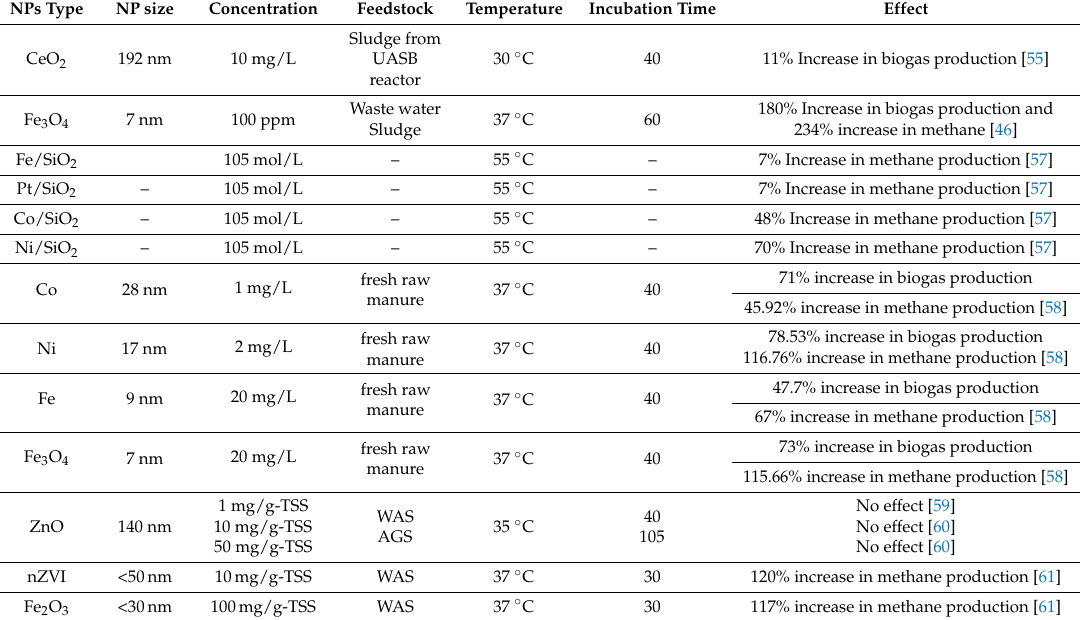
Table 1. Nano additives concentration and their impact on the biogas and methane production